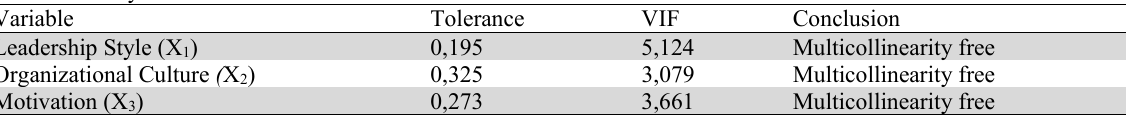
Multicollinearity with VIF